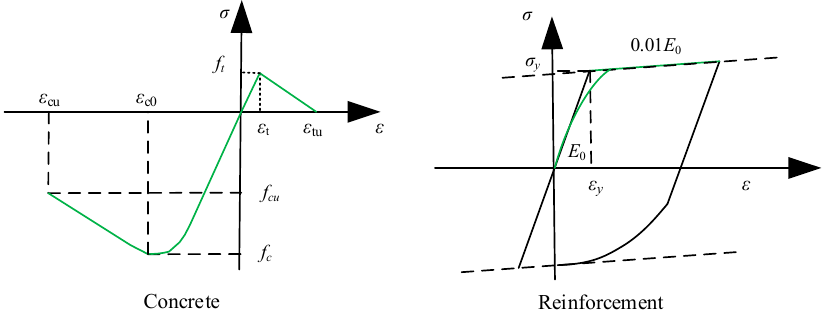
Figure 3. Constitutive models of materials.